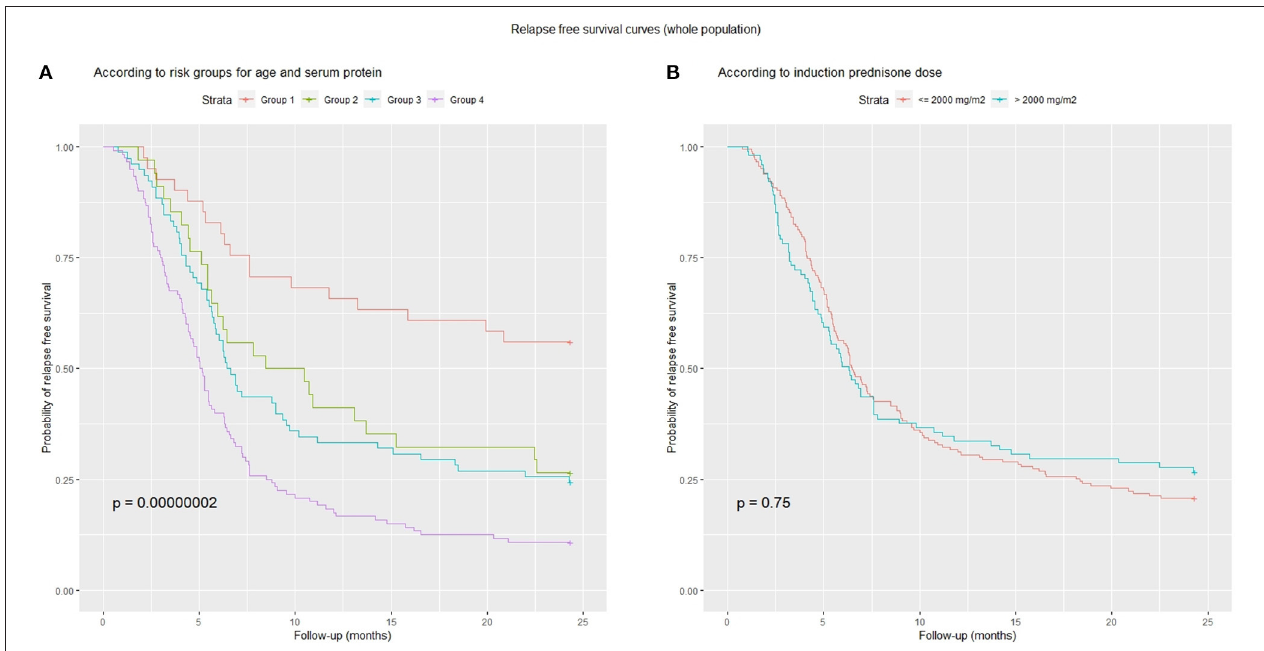
FIGURE 5 | Relapse-free survival curves: (A) combined risk groups according to age (cut-off 5.3 years) and serum protein (cut-off 4.2 g/dl): Group 1, low-risk for both; Group 2, high-risk for total proteins only; Group 3, high-risk for age only; Group 4, high-risk for both; (B) induction prednisone dose in binary form (threshold 2,000 mg/m 2